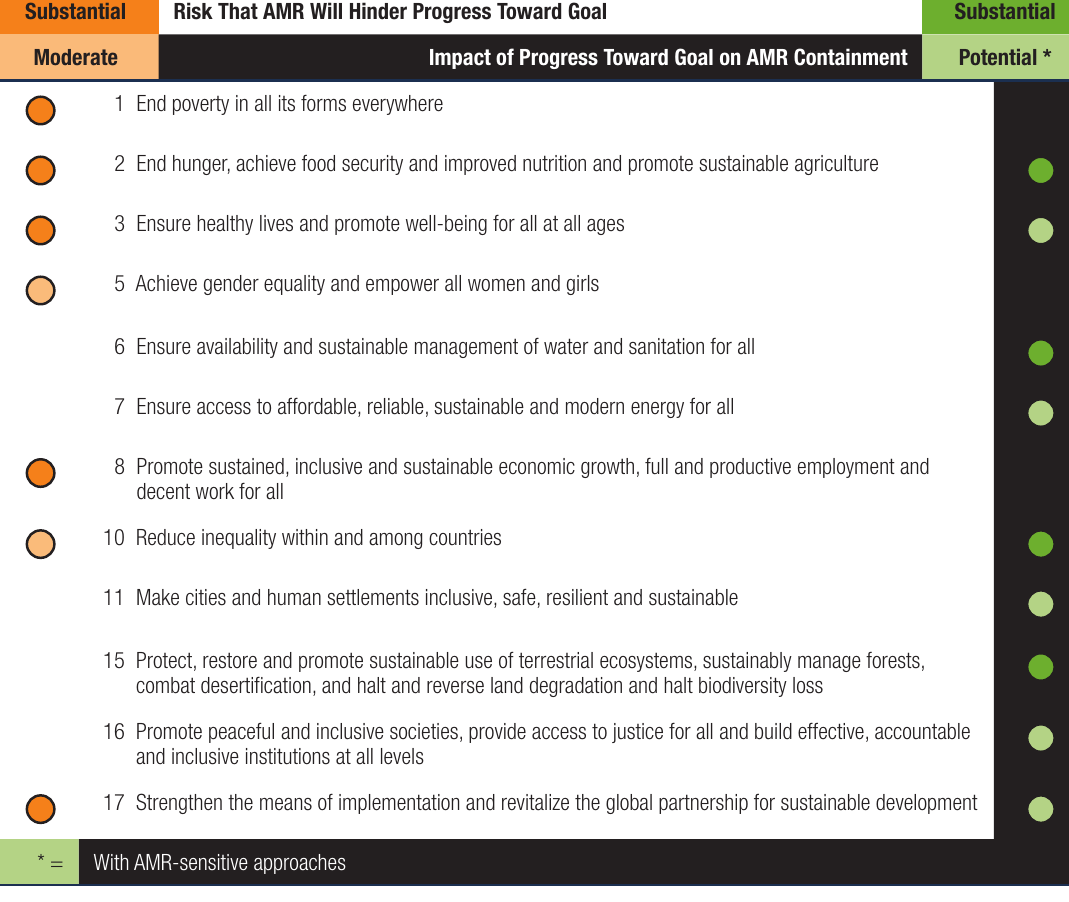
FIGURE 9. Synergies and Tensions with Global Development Goals for